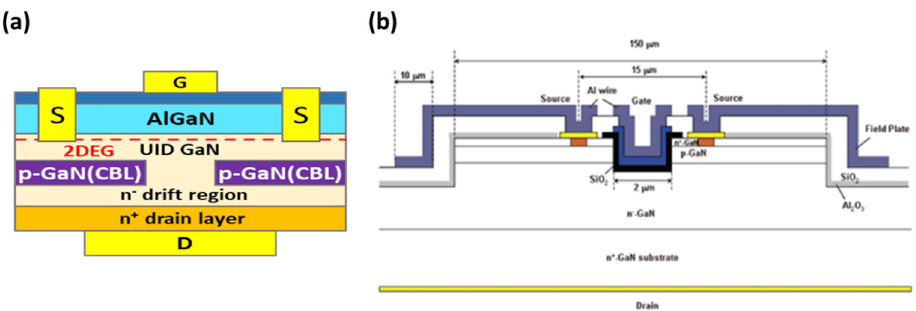
Figure 20. Cross-sectional structure of ( a ) CAVET [107] and ( b ) vertical GaN trench MOSFET [108]. Figure reproduced with permission from Japan Society of Applied Physics.